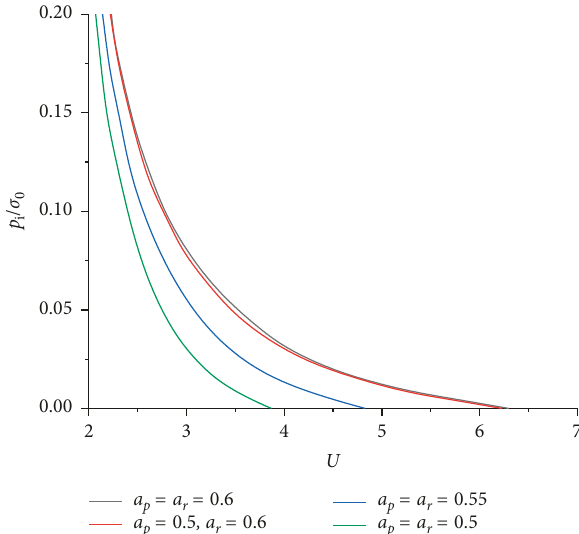
Figure 26: Evolution of plastic radii for different values of a considering seepage force.